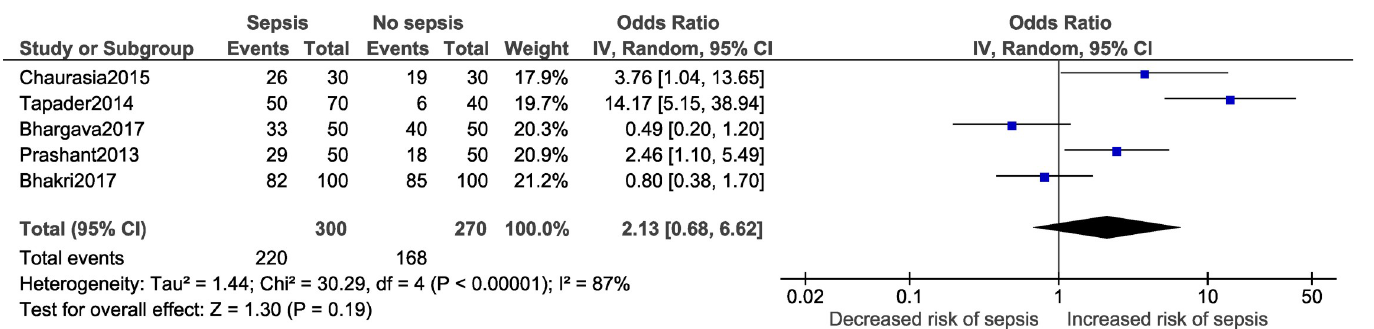
Fig 10. Forest plot showing a random-effects meta-analysis of neonates, with and without sepsis, born to mothers who had vaginal delivery.